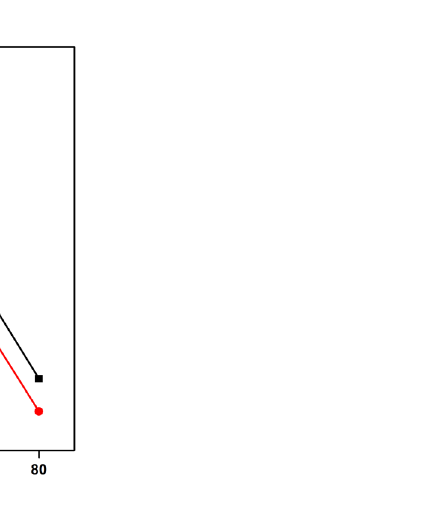
Figure 6. Throughput plot for proposed and existing